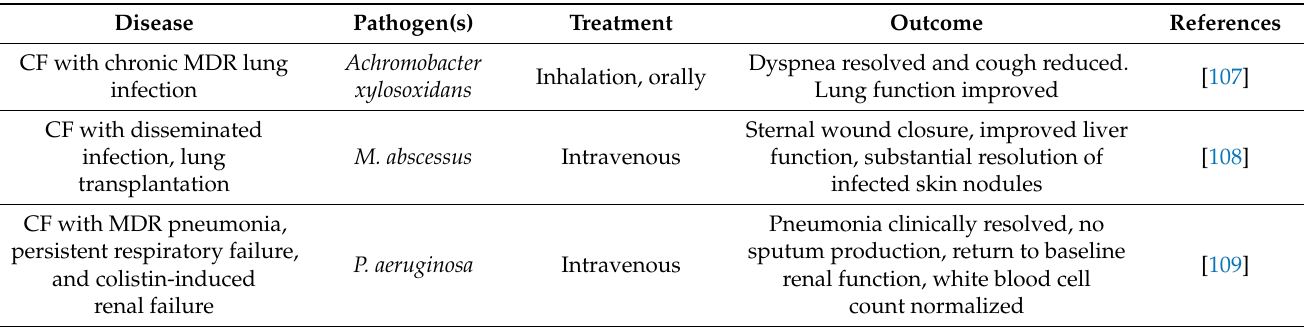
Table 2. Examples of clinical cases treated with phage